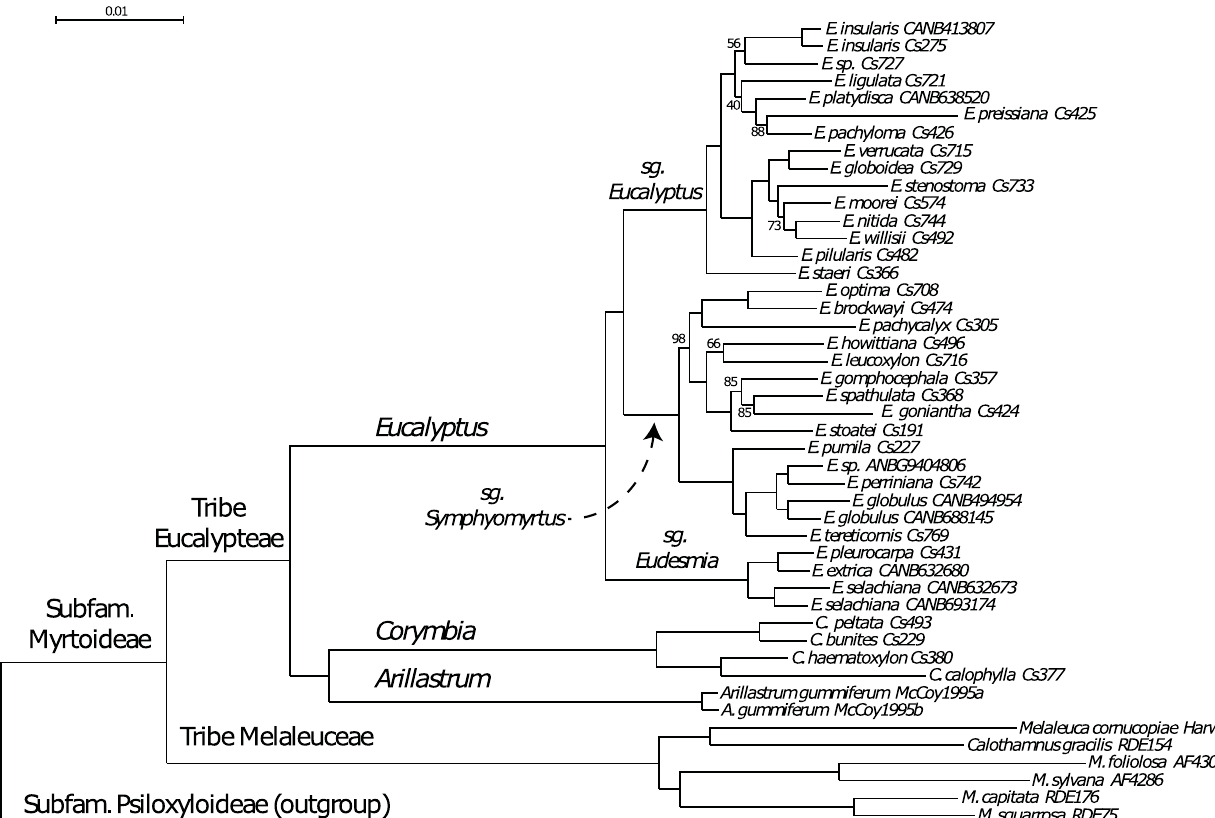
Fig 7. The single maximum likelihood tree of 47 taxa found by multiple searches (see Methods). Bootstrap values are shown and branch labels indicate higher taxonomic groups down to the rank of subgenera (sg). When bootstrap values are not shown, nodes had a bootstrap value of